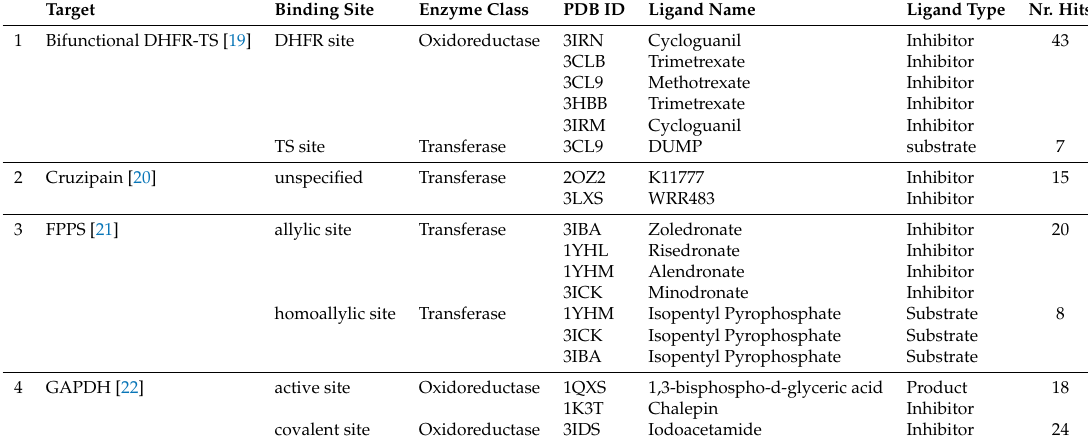
Table 1. T. cruzi targets used as input for the computational screening. The targets above the bold line have been thoroughly researched and there is a high confidence that modulating these targets will produce the desired effect in T. cruzi . The targets below the line have been at least researched for being involved in T. cruzi ’s survival. For each target, the target name, the specific binding site (in case of a multi-binding site target), the enzyme class, the PDB ID of the available structures, and the binding ligand are indicated. An independent screening was conducted for each target binding site. The last column on the right indicates the number of hit complexes predicted for each